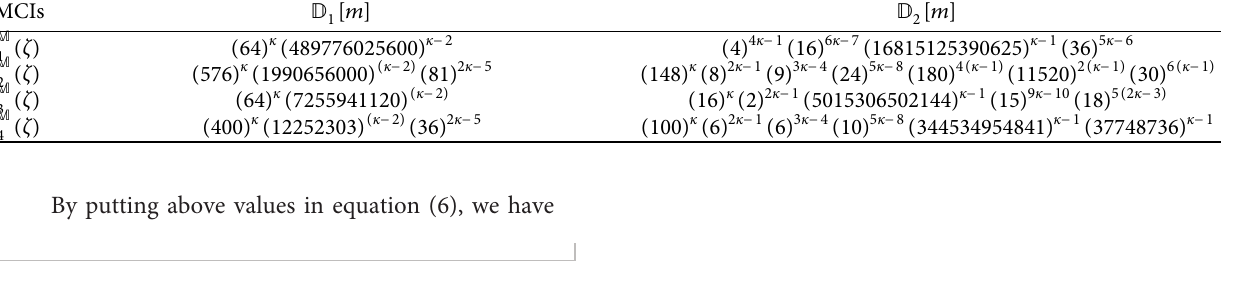
Table 10: Comparison between the values of D